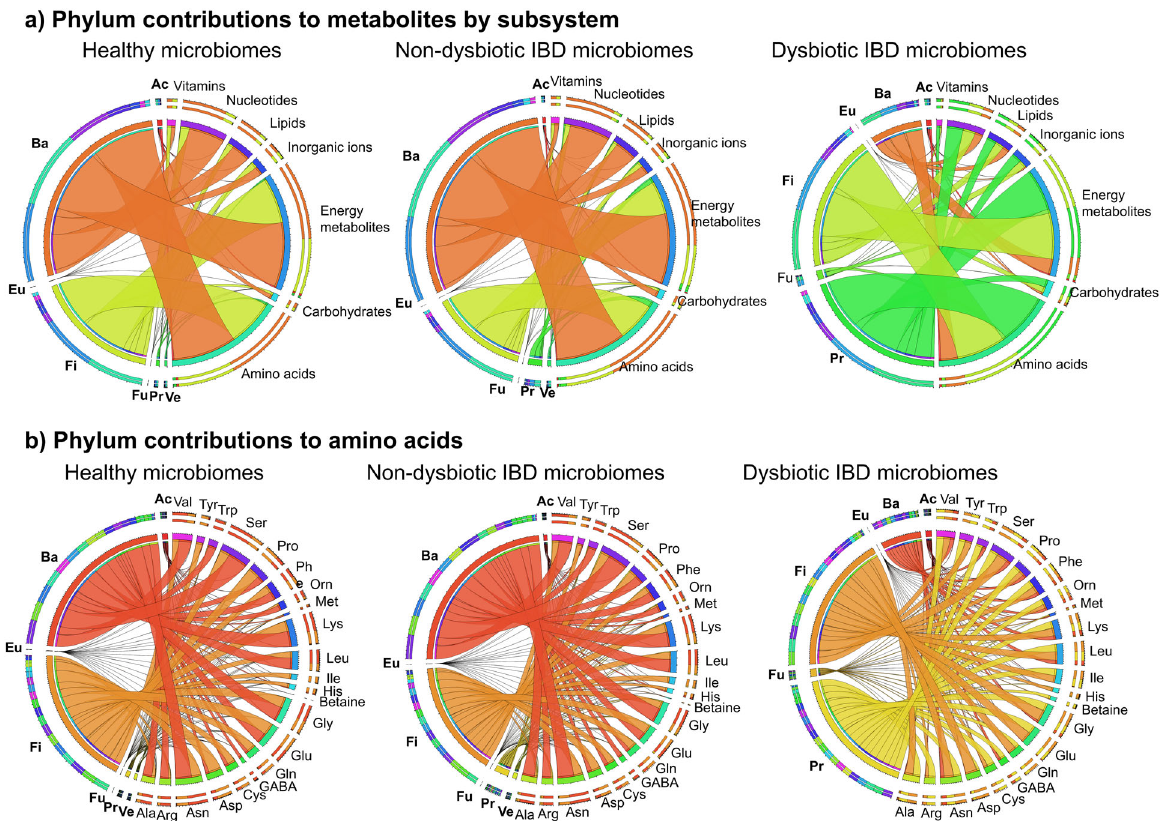
Fig. 5 Strain to metabolite contributions computed for the three clusters summarised by the seven most prominent phyla. Shown are the contributions (mmol/person/day, Supplementary Table 6) summarised separately for the 25 healthy, 63 non-dysbiotic IBD, and 20 dysbiotic IBD microbiomes. a Phylum-level contributions to all metabolites summarised by metabolite subsystem. b Phylum-level contributions to 22 amino acid metabolites. Ac = Actinobacteria, Ba = Bacteroidetes, Eu = Eurarchaeota, Fi = Firmicutes, Fu = Fusobacteria, Pr = Proteobacteria, Ve = Verrucomicrobia. Phyla that did not contribute in a given cluster are omitted for that